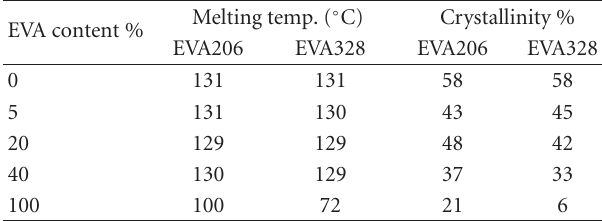
Table 1: Melting temperature and crystallinity percentage of HDPE/EVA